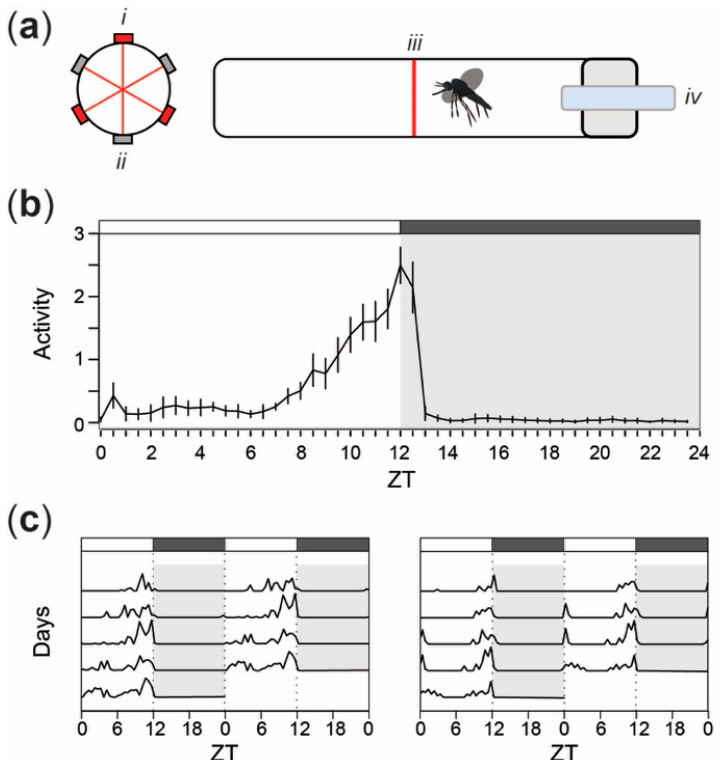
Figure 1. Locomotor and flight activity recordings in adult female Ae. aegypti mosquitoes show a bimodal pattern of activity, peaking in the last hours of the photophase. ( a ) Schematic representation of the locomotor activity monitoring system (Trikinetics LAM25, Waltham, MA, USA) showing a cylindrical glass tube containing an individual mosquito as viewed from the tube opening (left) and from the side (right). ( i ) Infrared laser emitters and ( ii ) detectors ( iii ) bisect each tube, which is enclosed with a ( iv ) sugar reservoir for constant access to 10% sucrose. ( b ) Mean locomotor activity pattern of 94 Ae. aegypti females in 12 h:12 h light-dark (LD) cycle. Values on the x -axis correspond to Zeitgeber time (ZT). Error bars represent the standard error around the mean. ( c ) Double-plotted actograms illustrating representative locomotor activity in two individual mosquitoes in 12 h:12 h LD cycles for 5 consecutive days, following a 48-hour period of light entrainment. Gray background and boxes above the actograms indicate the scotophase (i.e., dark period of the cycle) while white background and boxes depict the photophase (i.e., light-on phase).